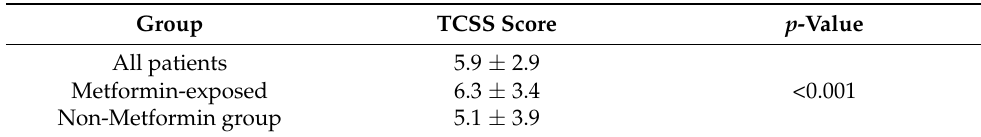
Table 4. Relationship between neuropathy score (Toronto clinical scoring system (TCSS)) and met- formin